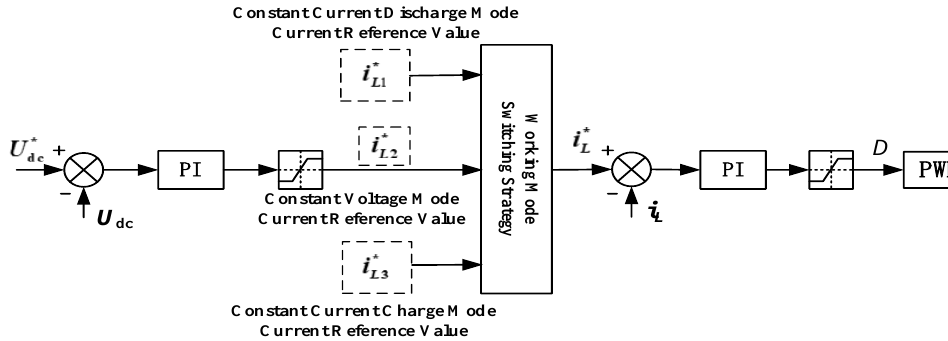
Figure 9. Principle diagram of supercapacitor operating mode switching.